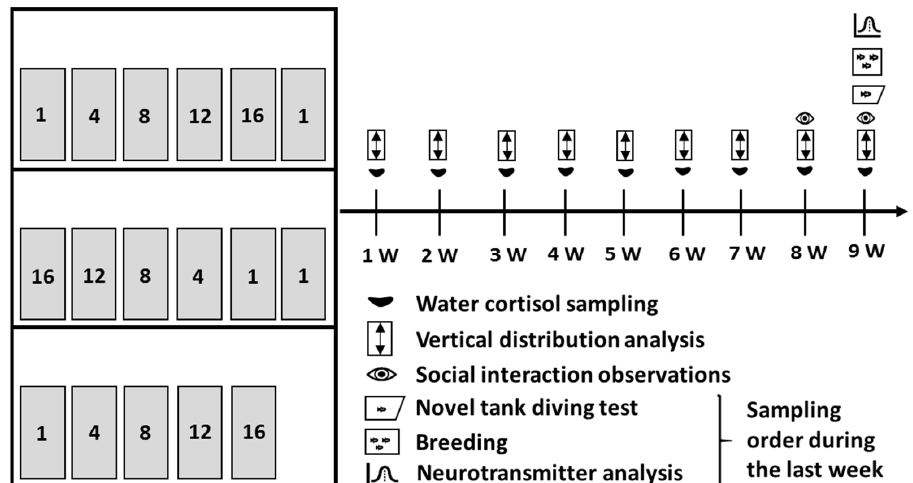
Figure 1. The experimental design. The left part of the figure illustrates the experimental set ‐ up, and the right part of the figure illustrates the time frame of the experiment. For the set ‐ up, each shelf held at least one tank from each density treatment. The densities were placed in increasing order from left to right on the top and bottom shelf, and from right to left on the middle shelf.